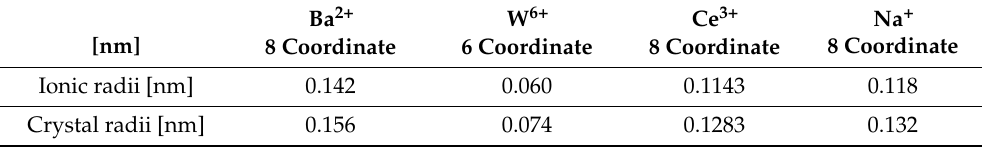
Table 1. Ionic and crystal